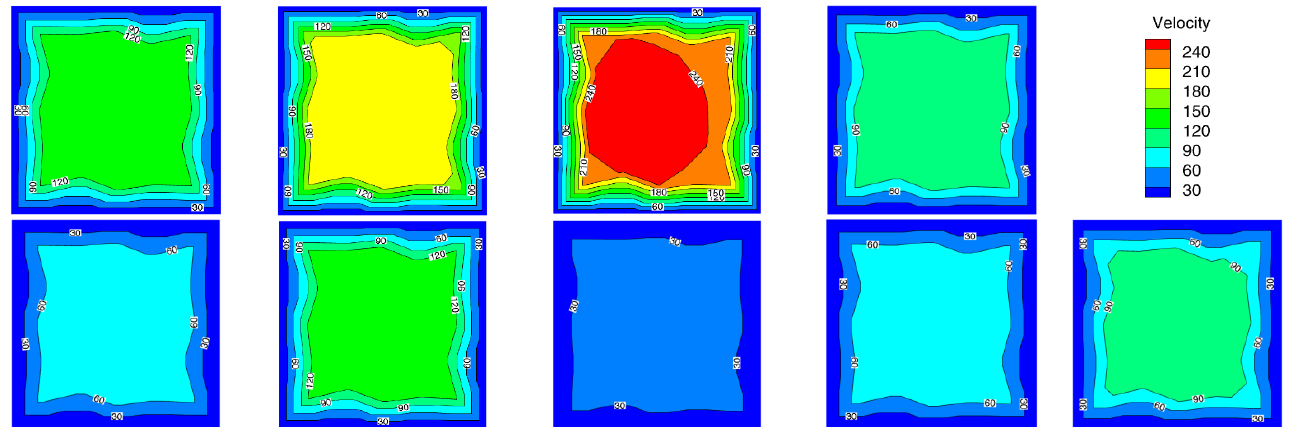
Figure 6. Air velocity of Inlet 2 of the return airway.